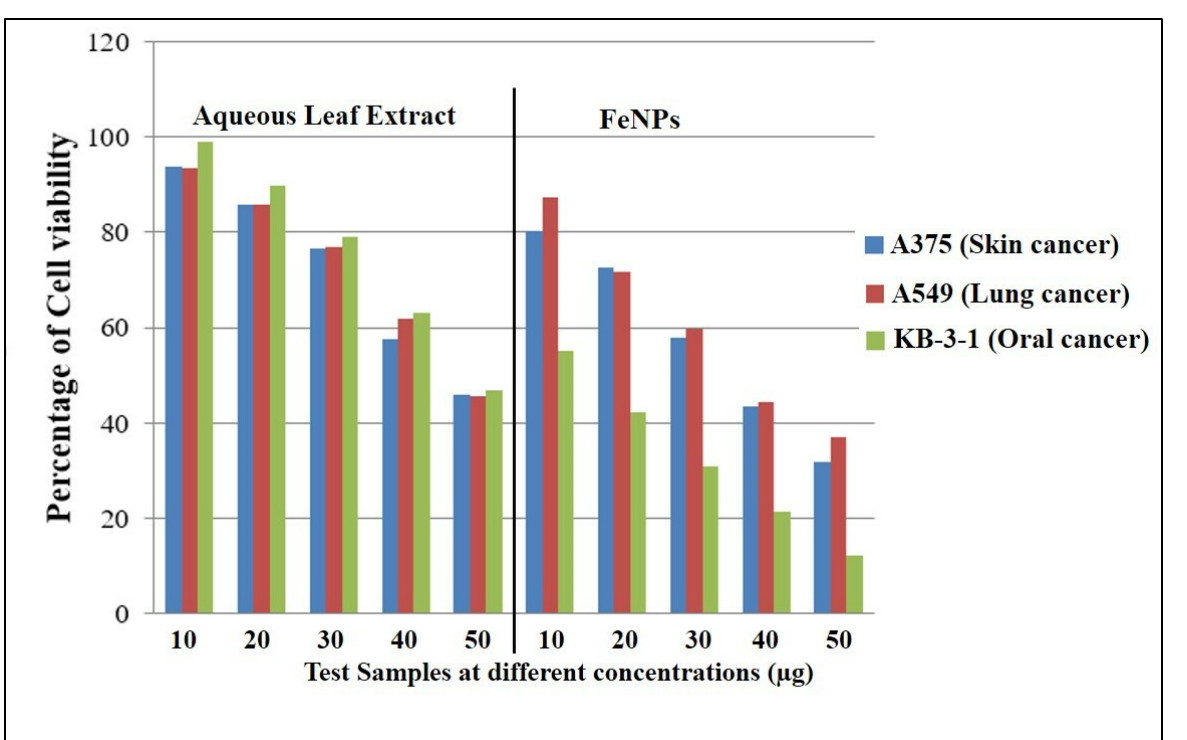
Figure 14. Percentage of cell viability for aqueous leaf extract of V. leucoxylon and its synthesized iron nanoparticles against different cancer cell lines.